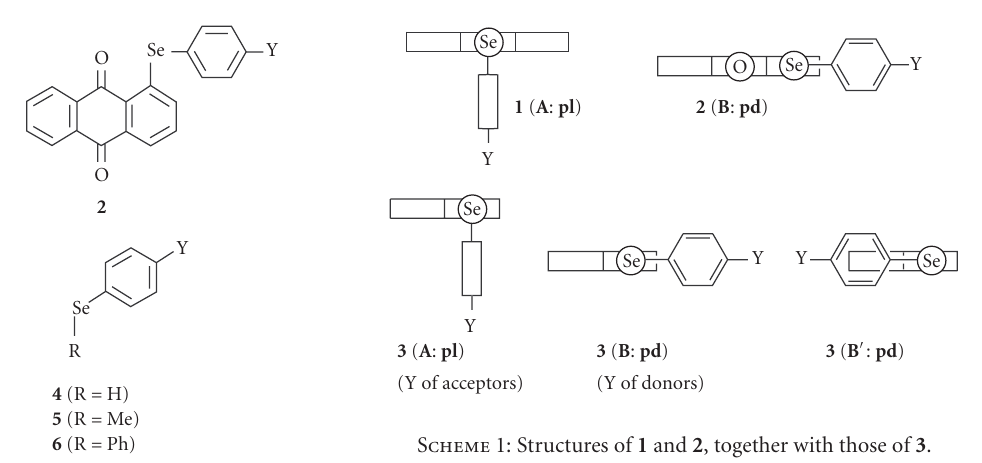
Scheme 1: Structures of 1 and 2 , together with those of 3